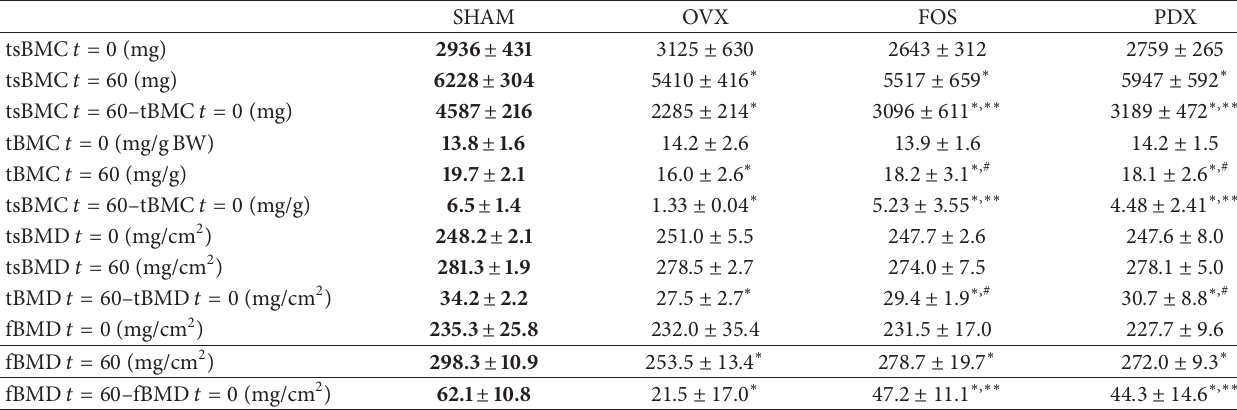
Table 4: Total skeleton bone mineral content (tsBMC) (expressed as mg and as mg/gBW); total skeleton bone mineral density (tsBMD) and femur BMD (fBMD) at the beginning ( 𝑡 = 0 ) and at the end of the study ( 𝑡 = 60 ) and their respective changes between 𝑡 = 60 and 𝑡 = 0 . SHAM OVX FOS PDX tsBMC 𝑡 = 0 (mg) 2936 ± 431 3125 ± 630 tsBMC 𝑡 = 60 (mg) tsBMC 𝑡 = 60 –tBMC 𝑡 = 0 (mg)